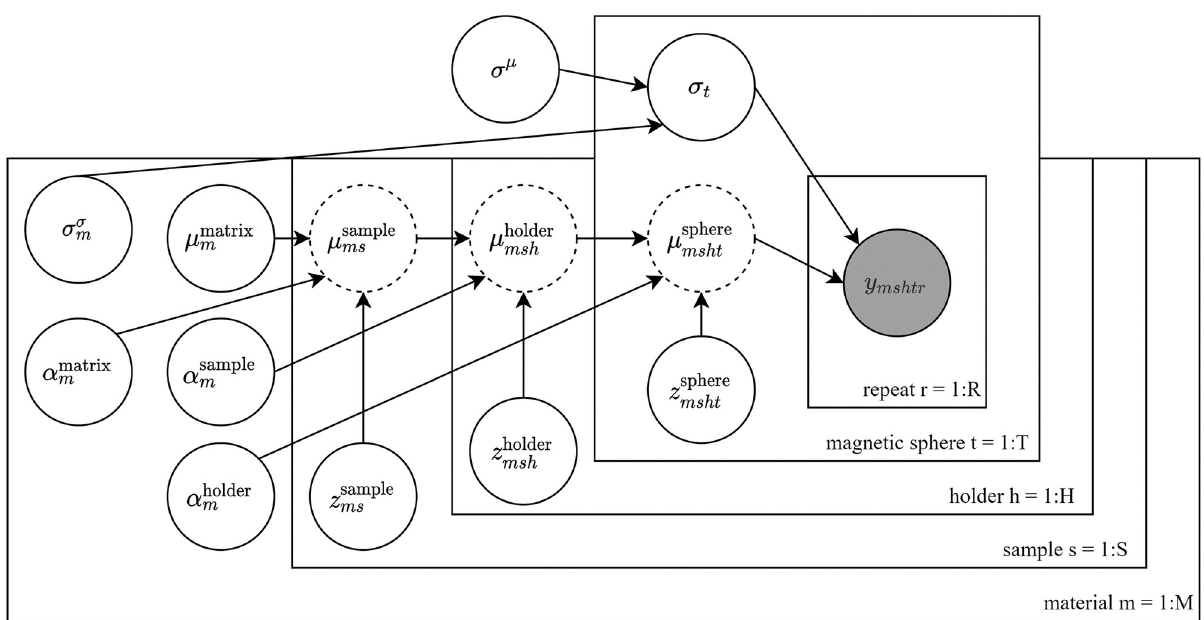
Fig 2. Heterogeneity model definition for quantifying spatial variation of viscoelastic parameters in 3D culture matrices. The mean value of each magnetic sphere is estimated as a sum of multiple level effects. There are m different matrix materials, h holders, s samples, h magnetic beads, and r repeats. Different 3D matrix material types are independent of each other, apart from sharing a common mean noise term. Partial pooling is used for each level of hierarchy to improve robustness. Specific level effects are denoted by a parameter vector μ , where the superscript is the level, and the subscript is the parameter corresponding the given observation (m, h, s, or t). The scale of the effect is provided by α with analogous super/subscripts. Non-centered parametrization is used for the level effects that are denoted using dotted lines (Eq 14). This model is run separately for estimating the absolute shear modulus (| G |) and the phase angle ( ϕ ) (denoted by y with subscripts). The gray color indicates observations (i.e. either | G |, or ϕ ). The used data has been z-score